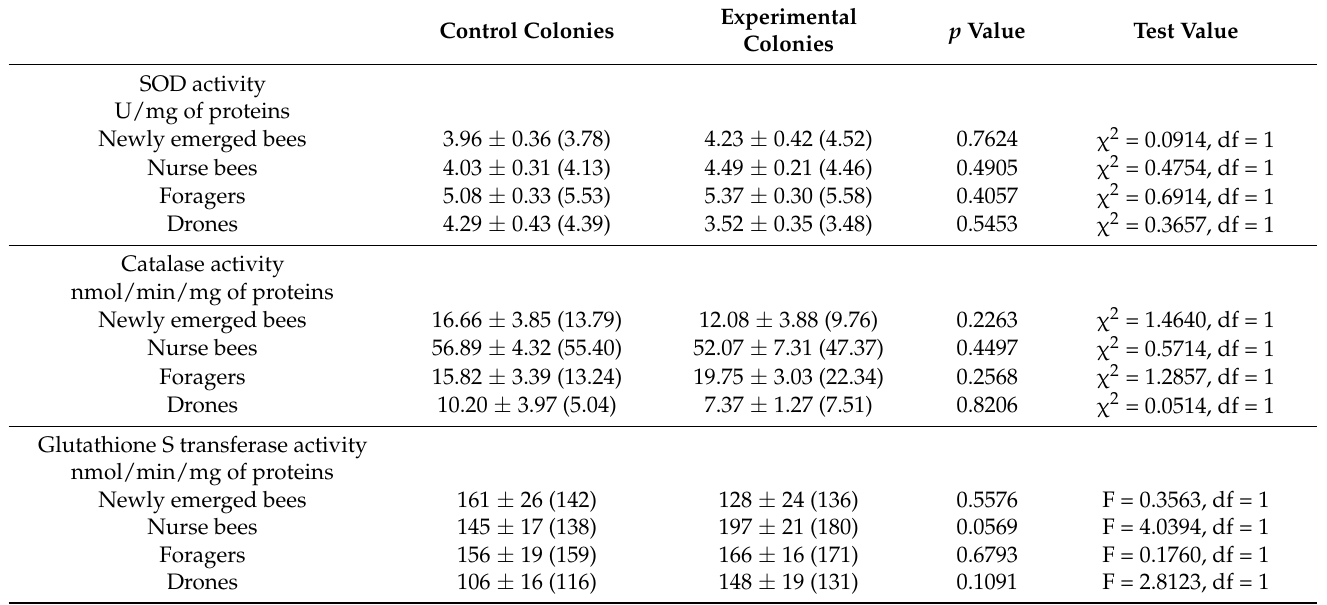
Table 2. Antioxidant enzymes of honey bees belonging to control and experimental colonies (queen caging + oxalic acid): SOD activity (U/mg of proteins, n = 10); catalase activity (nmol/min/mg of proteins n = 10); glutathione S transferase activity (nmol/min/mg of proteins). Values are reported as mean ± SE